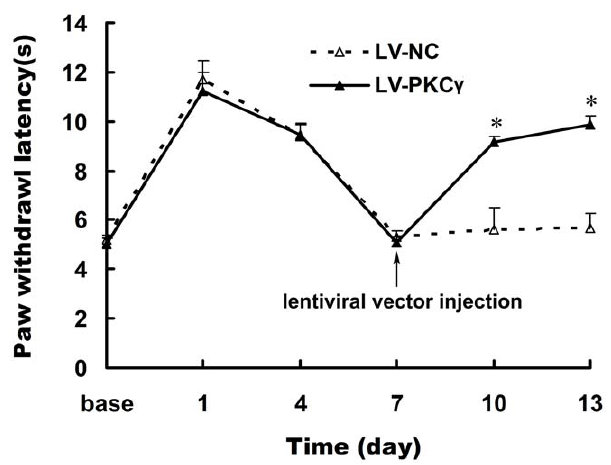
Figure 1. Effects of morphine injections on thermal paw withdrawal latencies (PWLs). The anti-nociceptive effect was measured 30 min after morphine injection. The baseline PWLs were determined before chronic morphine exposure (10 m g i.t., twice daily for 6 days). On day 7, rats were injected intrathecally with LV-NC or LV- shPKCa˜. Data are presented as mean 6 SD. * P , 0.05, compared with